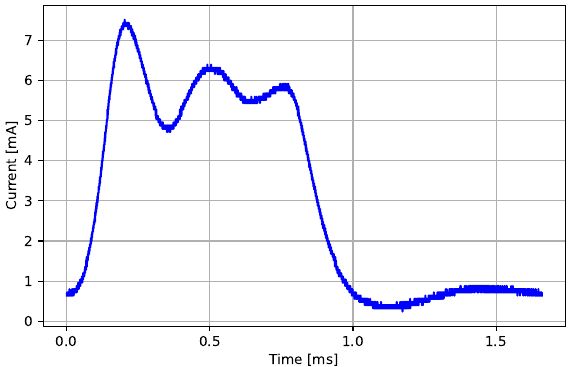
Figure 7. Current consumption profile of an MCU tick